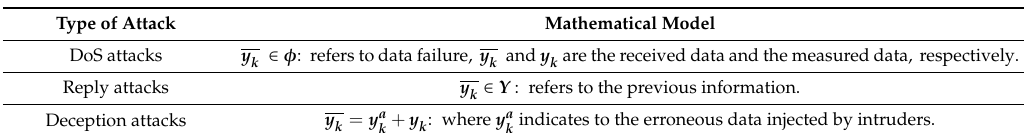
Table 9. Mathematical models of cyber attacks